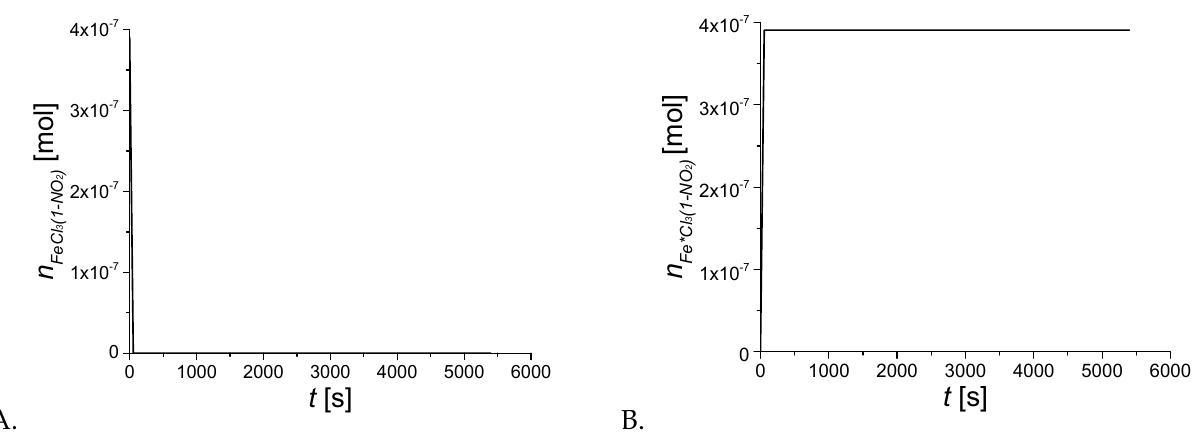
Figure 5. Catalyst forms vs. time. ( A ) Non-activated form. ( B ) Activated form.